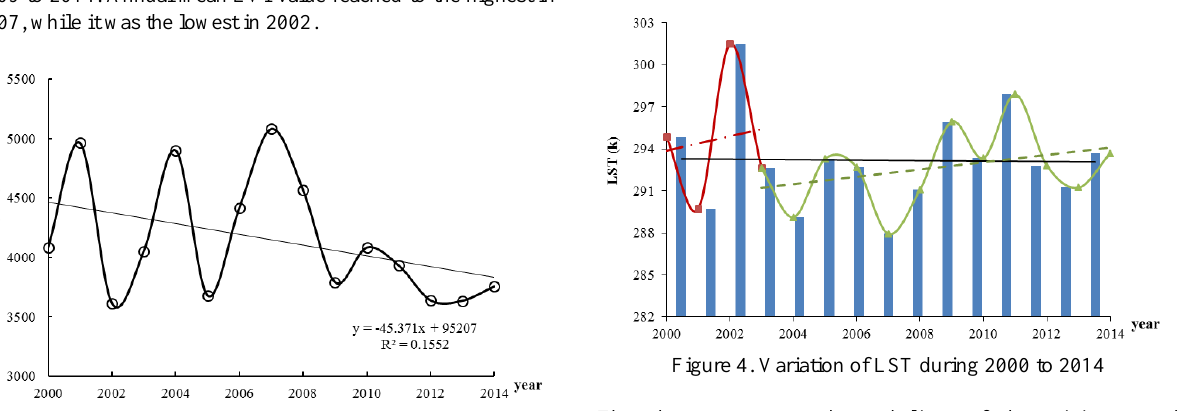
Figure 2. Variation of EVI during 2000 to 2014